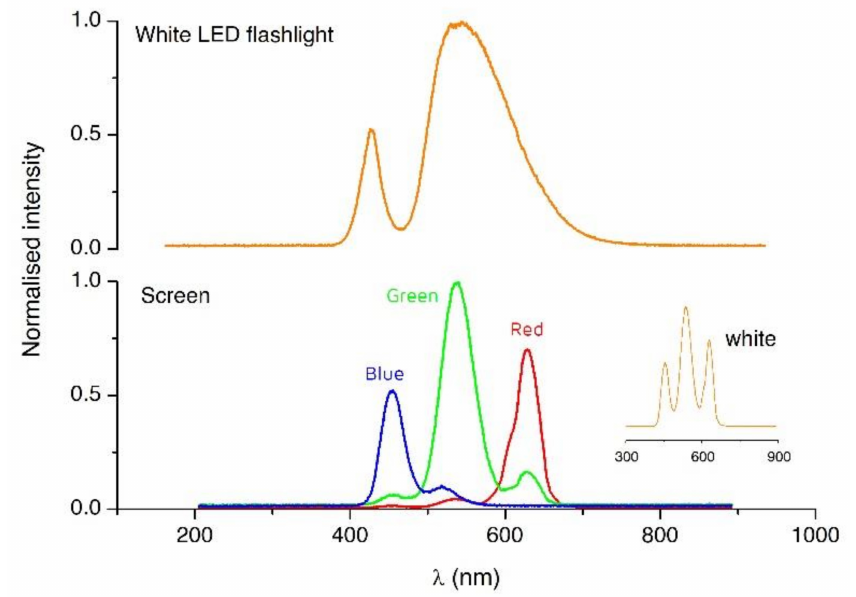
Figure 3. Light spectra from an iPhone 7. Top: LED flashlight. Bottom: individual spectra obtained from the screen emitting red (255,0,0), green (0,255,0), and blue (0,0,255) light. The inset shows the spectra obtained from a white (255,255,255)